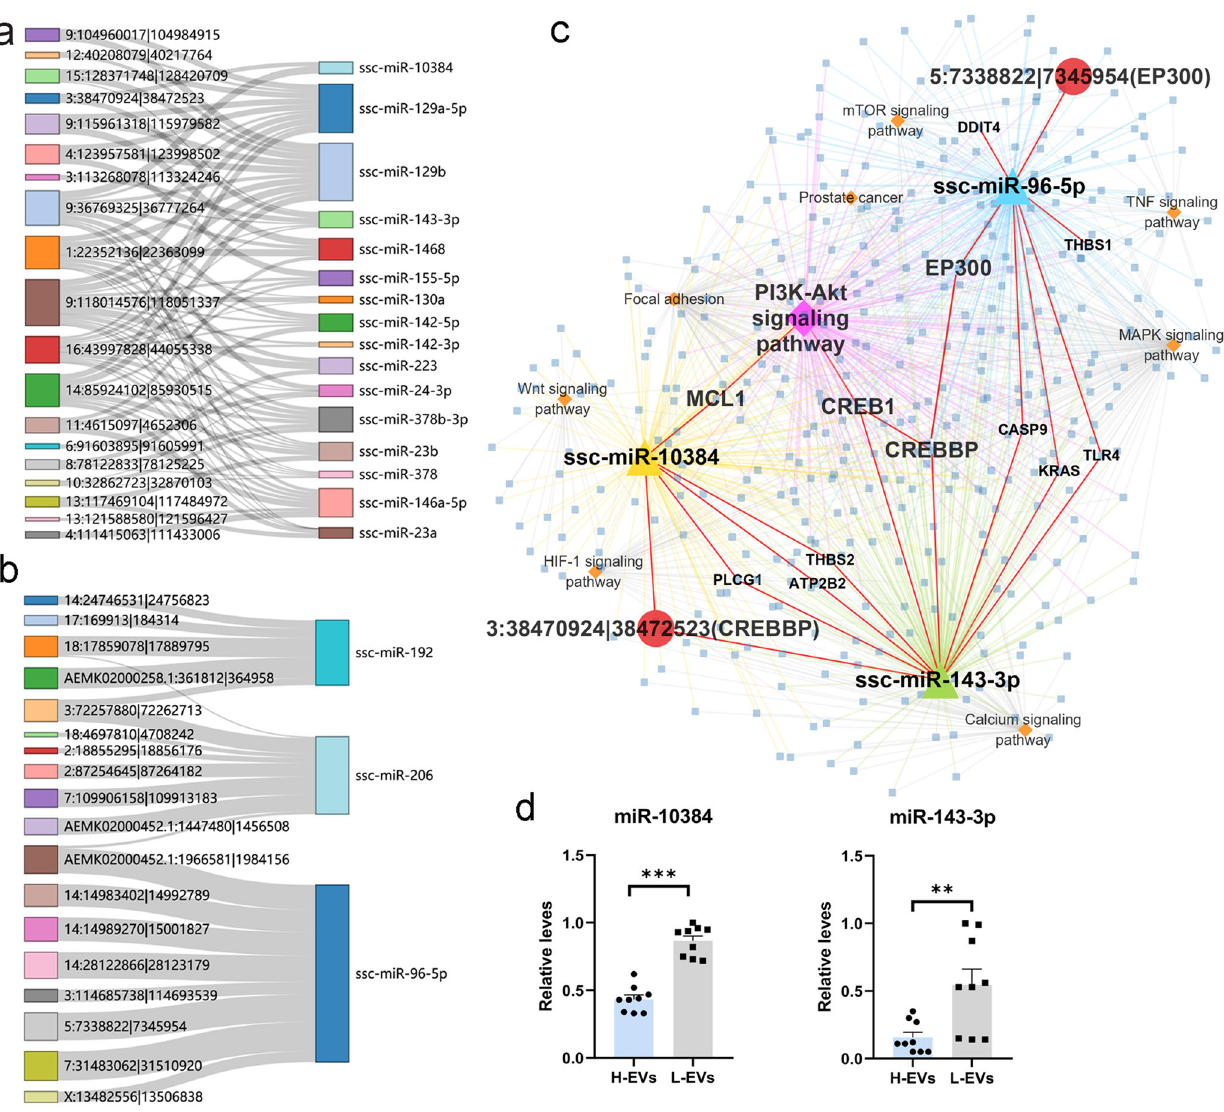
Fig. 4 Regulatory networks of DEC-DEM-genes. a The regulatory network of upregulated circRNAs and downregulated target miRNAs in H group. b The regulatory network of downregulated circRNAs and upregulated target miRNAs in H group. c A network of two important circRNAs, their target DEMs, target genes and related pathways. d The relative expression of miR-10384 and miR-143-3p in H-SPEVs and L-SPEVs was detected by qPCR. ** P ≤ 0.01, *** P ≤ 0.001 (Student ’ s t test), n = 3 for each (Fig. 7a and Supplementary Fig. 2). Immuno fl uorescence data indicated that MCL1 and BAX colocalized in the cytoplasm and tails of sperm, which provided new evidence for the interaction